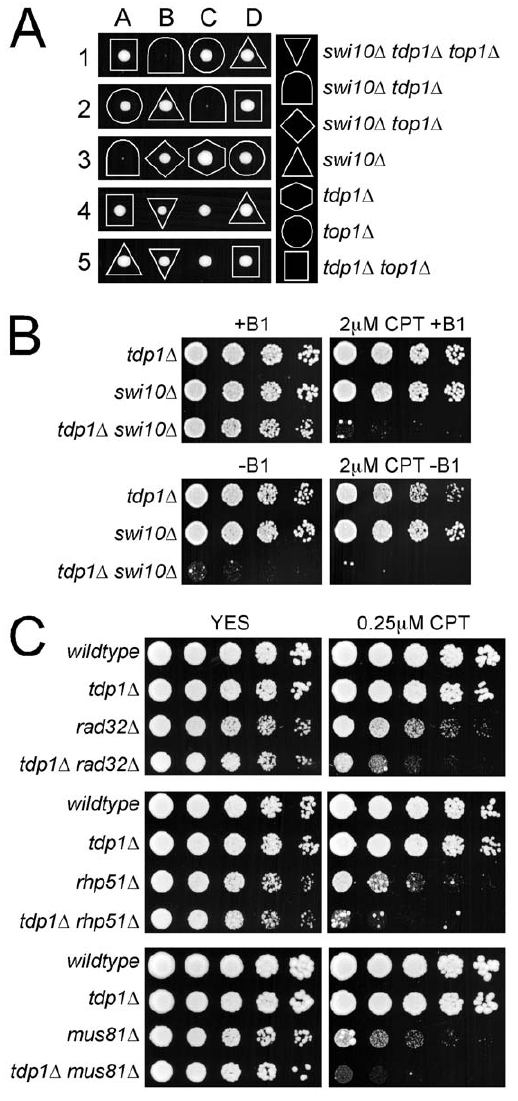
Figure 5. Tdp1-deficient cells depend on Swi10, but not on homologous recombination repair factors, to prevent Top1- induced cell death. (A) A representative tetrad dissection is shown of a cross between swi10 D and the top1 D tdp1 D double mutant. The key depicts the genotypes present, which are denoted by various shapes placed around each colony. Wildtype cells do not have a shape placed around them. (B) Serial dilutions of the indicated strains expressing Top1 under a thiamine repressible promoter were spotted onto control or CPT containing media with ( + B1) or without (-B1) thiamine to repress or induce Top1 expression, respectively. (C) Five fold serial dilutions of the indicated strains were spotted onto rich media that contained either no drug (YES), or camptothecin (CPT). Plates were incubated at 32 u C.